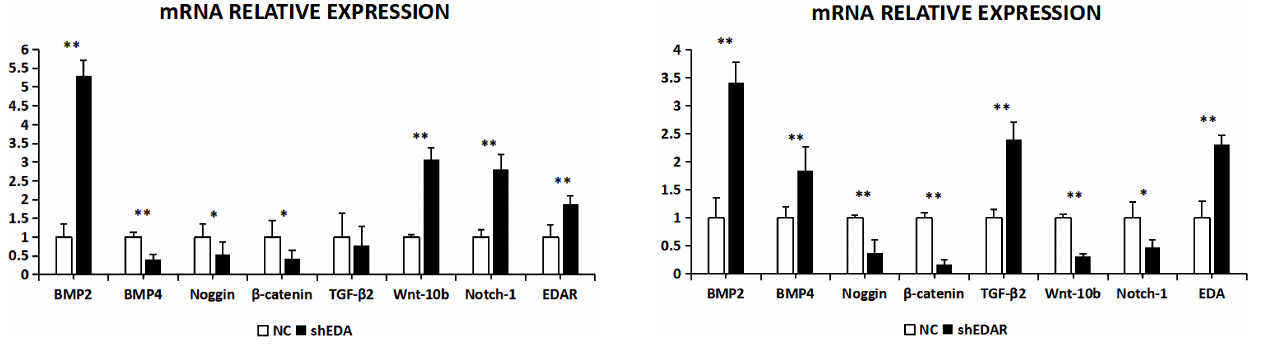
Figure 9. The mRNA relative expression of BMP2, BMP4, noggin, β -catenin, TGF- β 2, Wnt-10b, NOTCH1, and EDAR after EDA in- terference. Note: ∗ significant difference. ∗∗ Extremely significant difference.